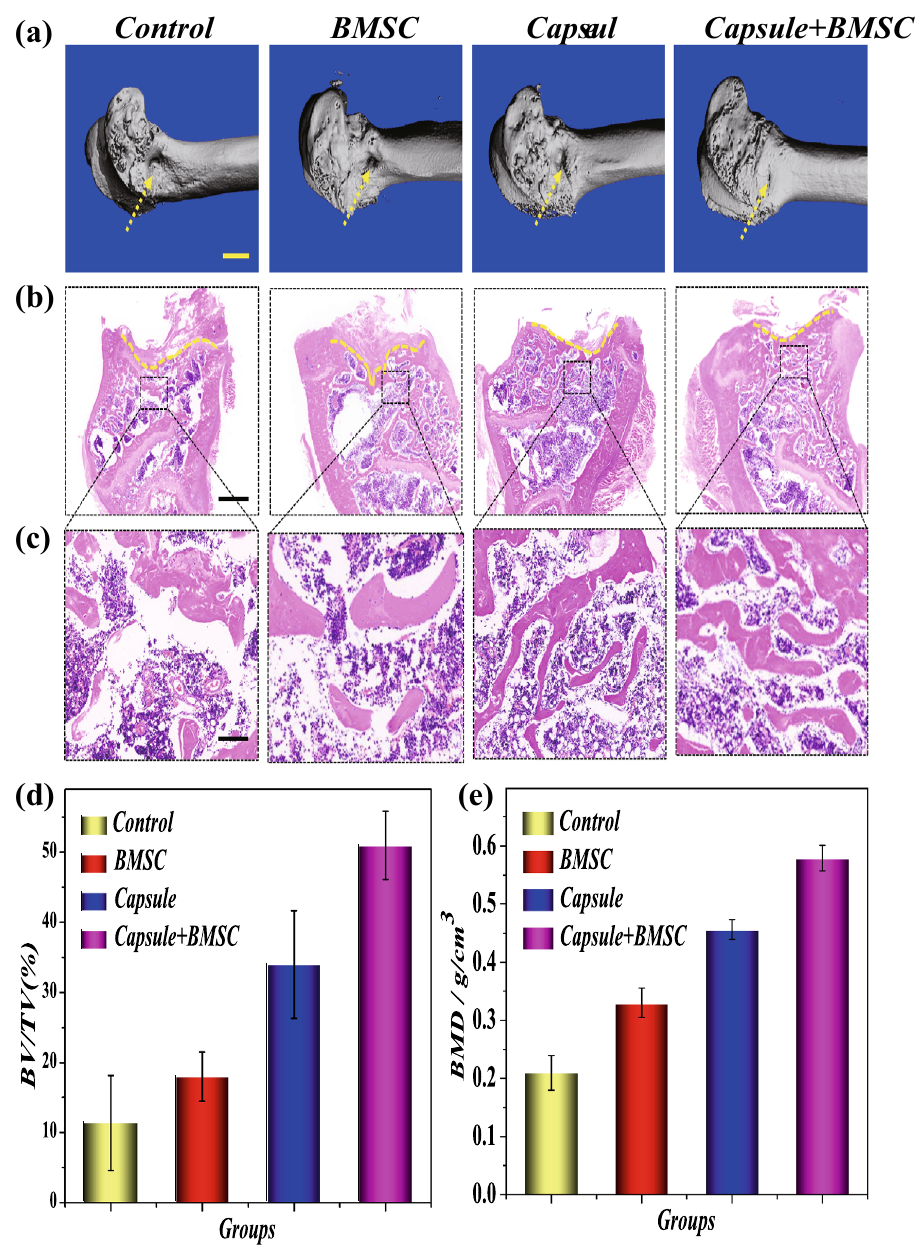
Fig. 5 Representative a micro-CT reconstruction images, b , c H&E staining and d , e quantitative statistic of BV/TV and BMD of different groups: Control, Capsule, and Capsule-BMSC groups. Scale bars are 5 mm in ( a ), 1 mm ( b ) and 200 μm in ( c ). BV/TV: bone volume/total vol- ume; BMD: bone mineral